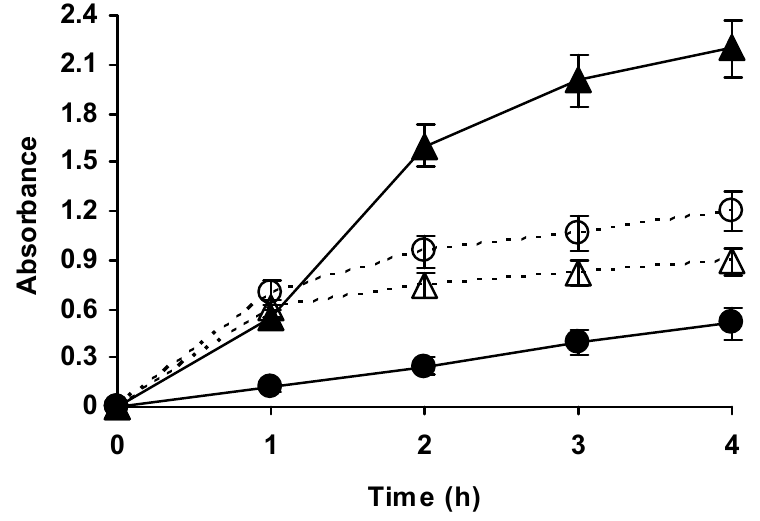
Figure 3. Courses of hydrolysis of casein at pH 9 and 50 (circles) or 60 °C (triangles) catalysed by free (empty symbols, dashed line) or immobilized Alcalase (solid symbols, solid line). The concentration of enzyme (free or immobilized) was 0.005 mg/mL in all cases. Other conditions may be found in methods section.